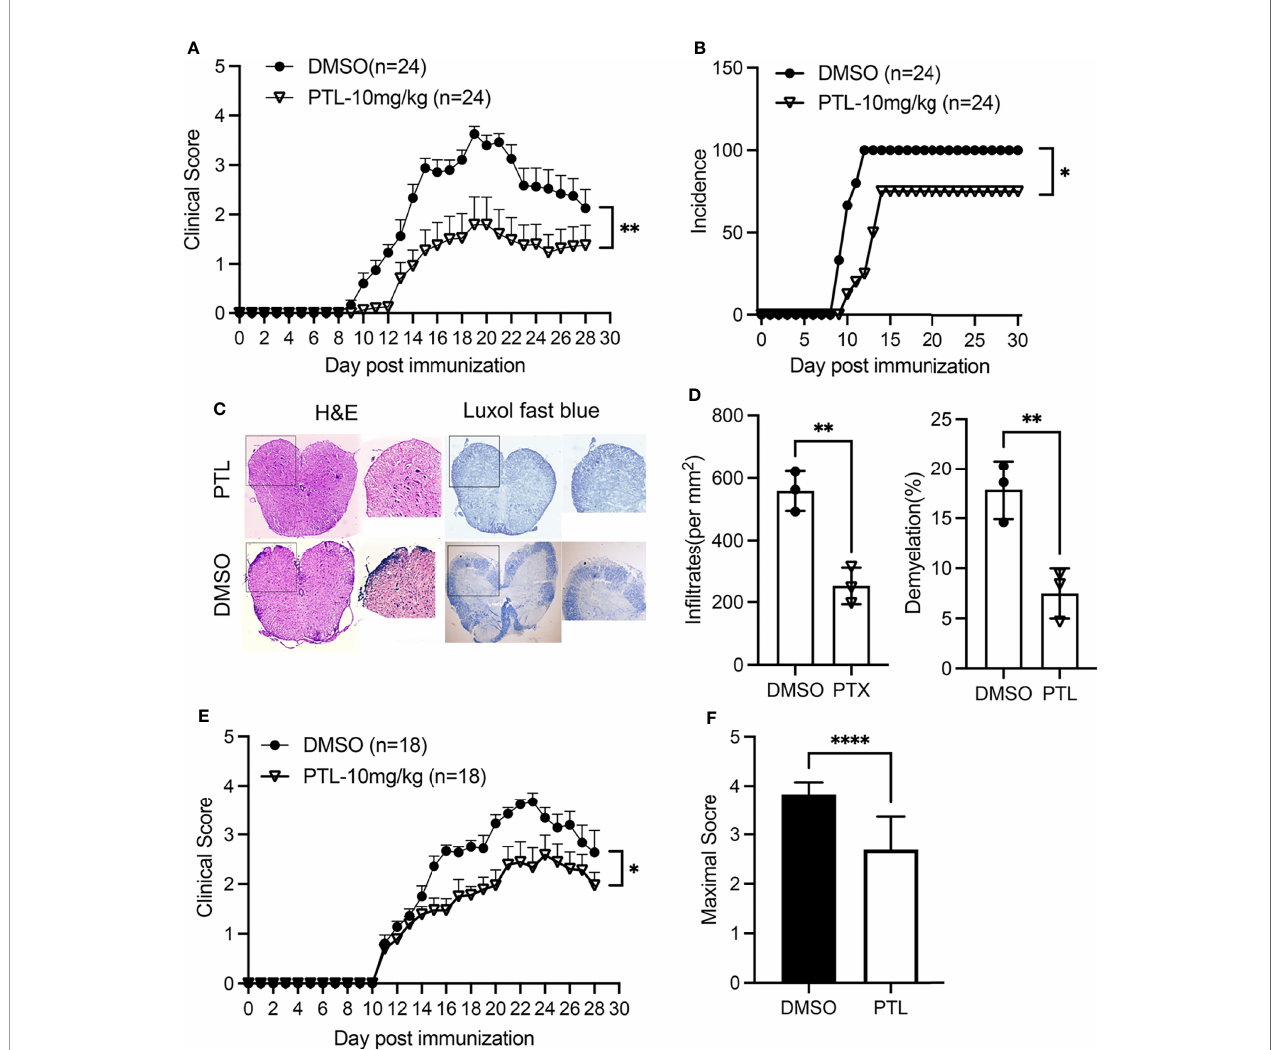
FIGURE 1 | PTL ameliorated the clinical symptoms of EAE mouse. (A) Mean clinical scores of EAE mice treated with PTL (10 mg/kg) or DMSO ( n = 24 mice/group). (B) Incidence of EAE in the DMSO group and PTL (10 mg/kg)-treated group ( n = 24). (C) H&E staining and Luxol fast blue staining of spinal cords isolated from DMSO-treated mice and PTL-treated mice ( n = 3 mice/group) on day 21 after immunization. (D) Quanti fi cation of spinal cord in fi ltrates and demyelination in the sections, presented as in fi ltrates per mm 2 (left) and demyelination area relative to total analyzed area (right) of DMSO-treated mice and PTL-treated mice shown in (D, E) Mean clinical scores of EAE therapy with PTL (10 mg/kg) or DMSO ( n = 18 mice/group). (F) Mean maximum clinical score of EAE mice treated with PTL (10 mg/kg) or DMSO. Data shown are representative of 3 independent experiments. The error bars shown were mean ± SD. * p < 0.05, ** p < 0.01, ****p < 0.001 using unpaired Student ’ s t -test. Two-way analysis of variance (ANOVA) followed by Bonferroni ’ s post-hoc test, was applied for multiple comparisons. For EAE scoring, groups were compared using Mann – Whitney U